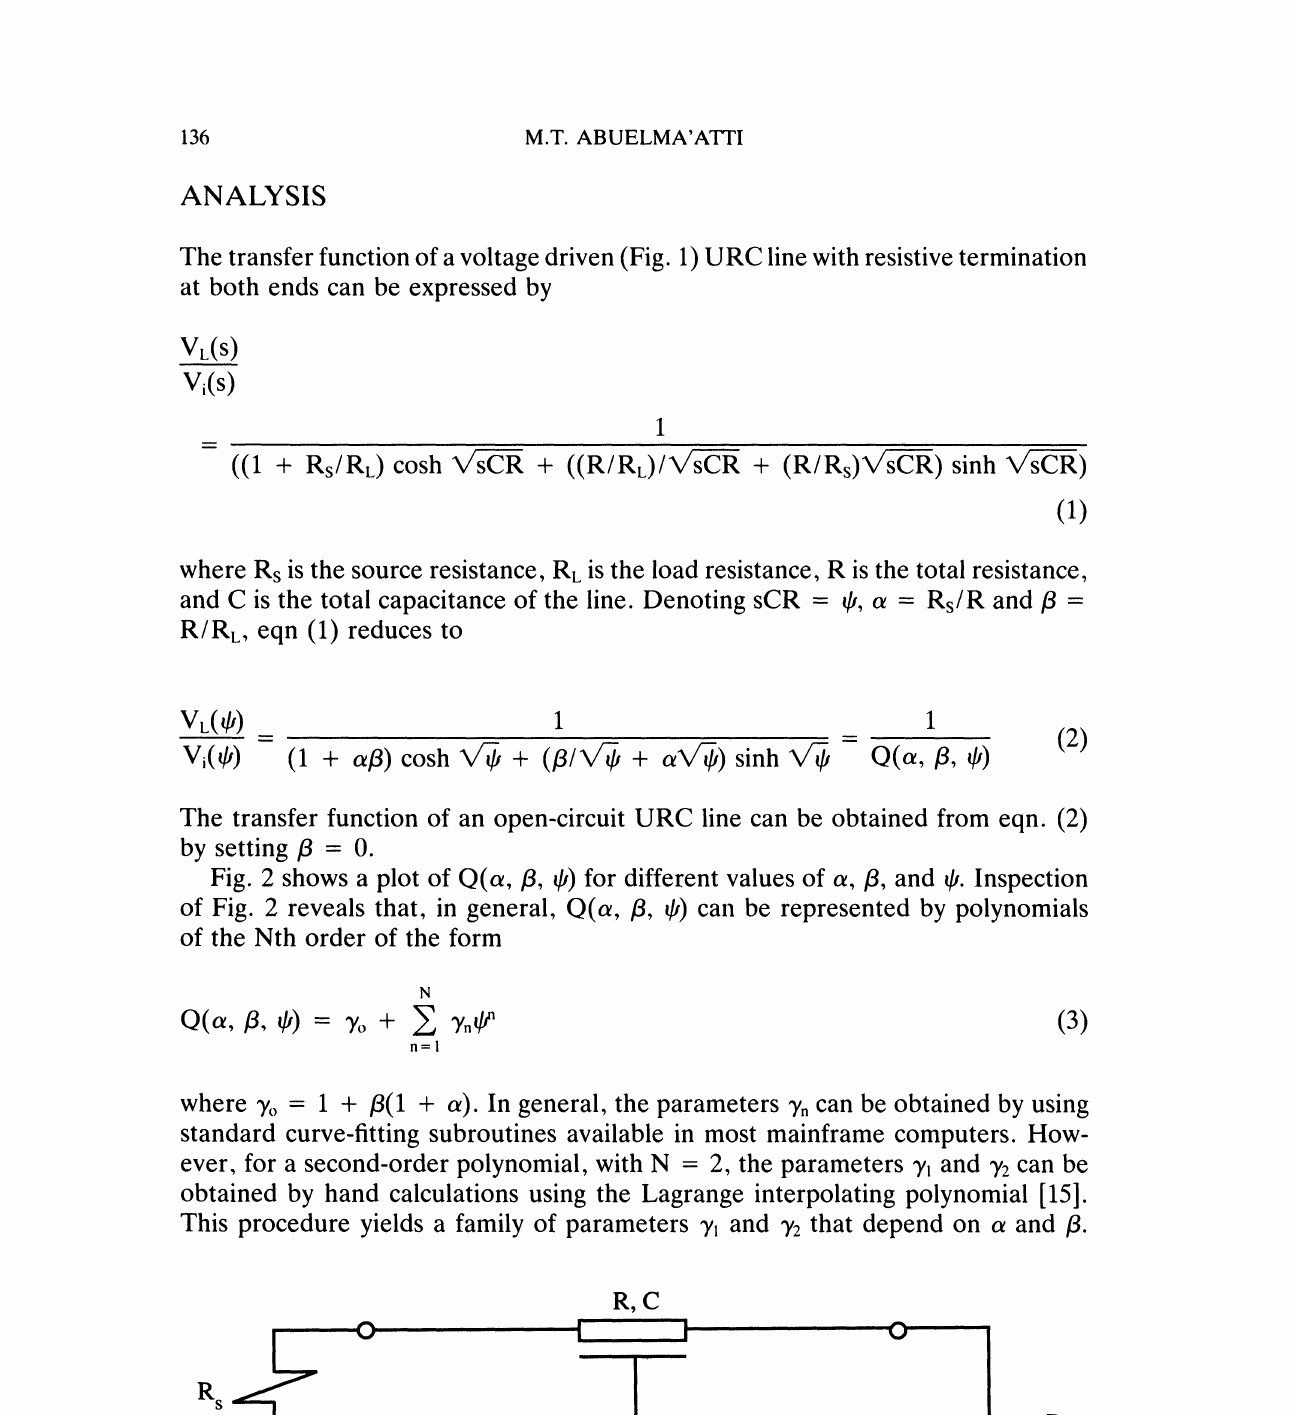
FIGURE Voltage-driven URC line with resistive termination at both